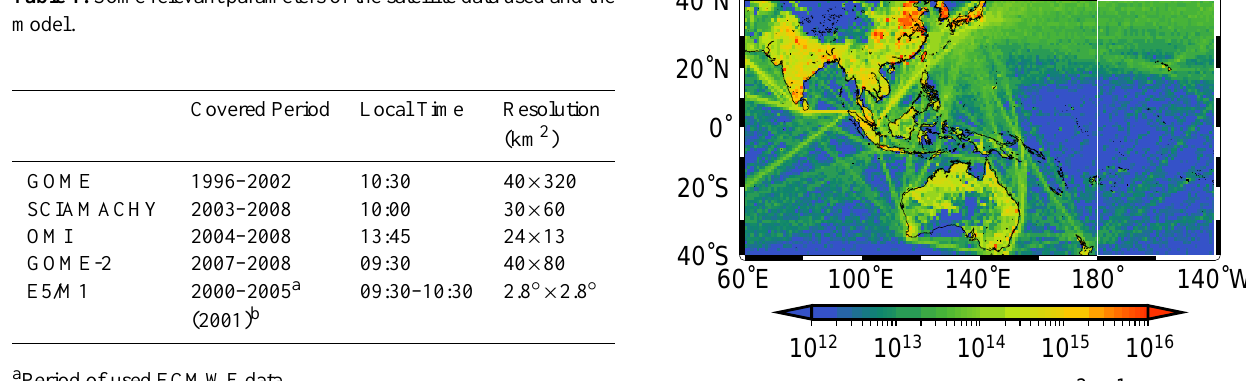
Table 1. Some relevant parameters of the satellite data used and the model.